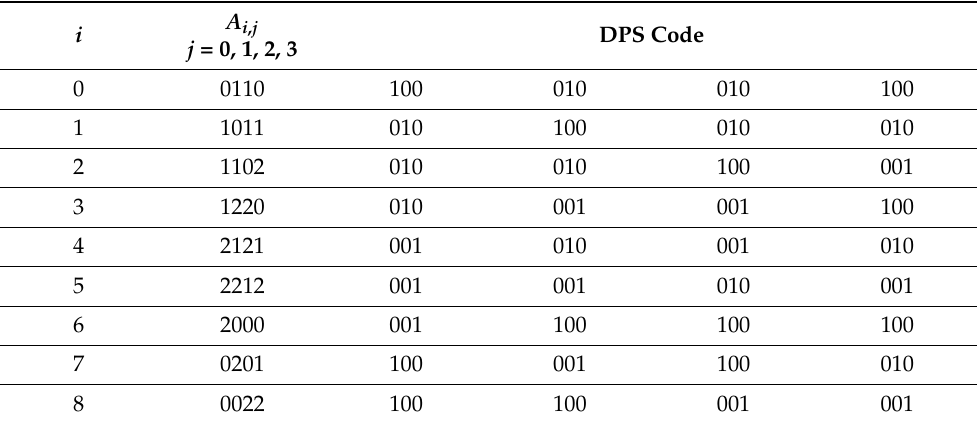
Table 2. DPS code sequence for P = 3.